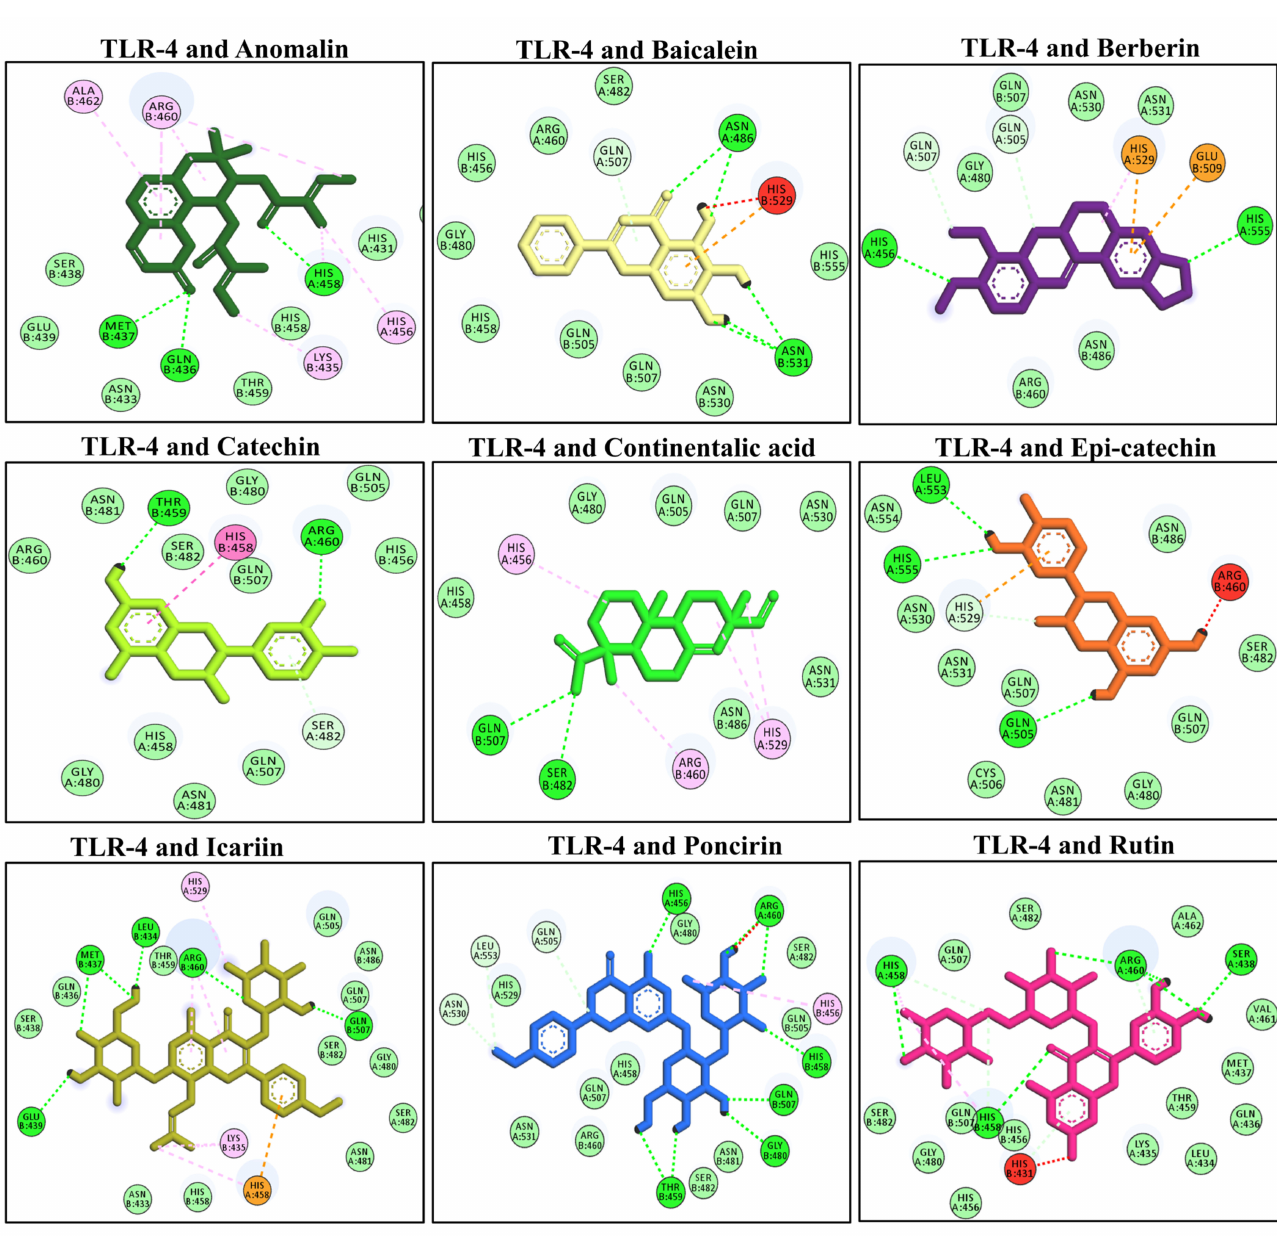
Figure 4. The molecular docking analysis of the selected compounds with the TLR-4 receptor using AutoDock Vina software. The molecular docking showed binding of the studied ligand with the TLR-4 via multiple hydrophilic and hydrophobic bonds. The ligand and protein interactions were visualized in Discovery Studio Visualizer_16 and ligands whose negative binding energy was high were